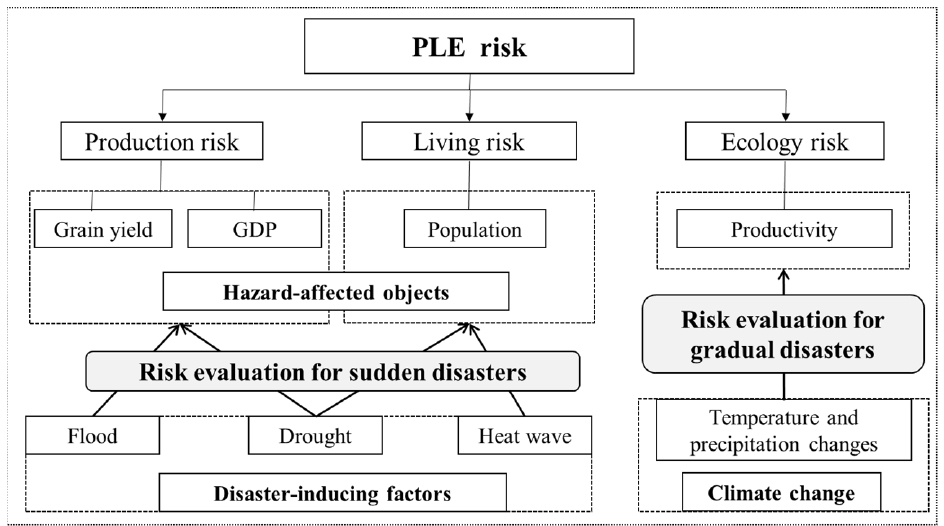
Figure 1. Evaluation system of production, living, and ecology risks. Based on the above data, the PLE risks are classified at the grid scale in China by using the standard deviation multiple method [58] (Figure 2). Areas with a high production risk account for approximately 17% of the total area of China, according to the obtained spatial statistics (Figure 2A). Areas with a high living risk are concentrated in North China and some areas along the southeastern coast (Figure 2B), accounting for 12% of the total area of China; areas with an intermediate living risk account for 11%. Additionally, areas with a high ecological risk account for